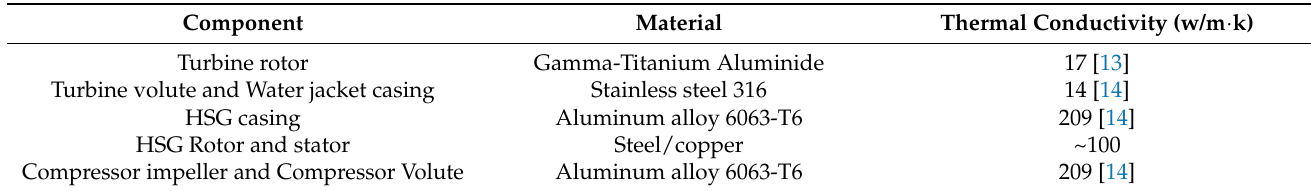
Table 1. MGT components material properties.